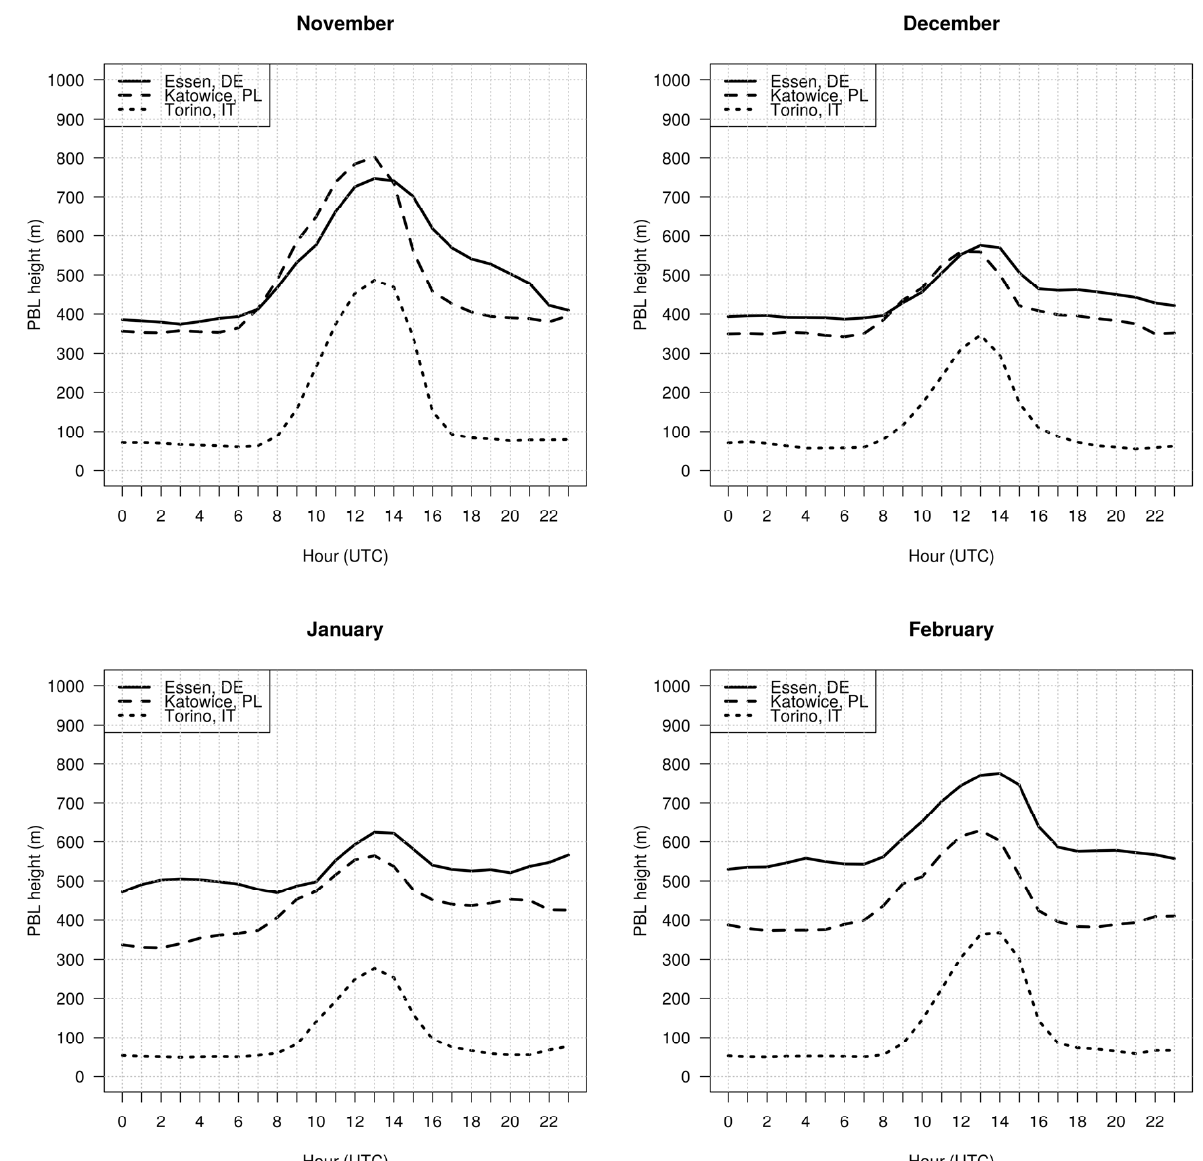
Figure 4. PBL height diurnal pattern in Torino (North-Western Italy), Essen (North-Western Germany), and Katowice (Southern Poland) during the cold season (average values from 1979 to 2020).